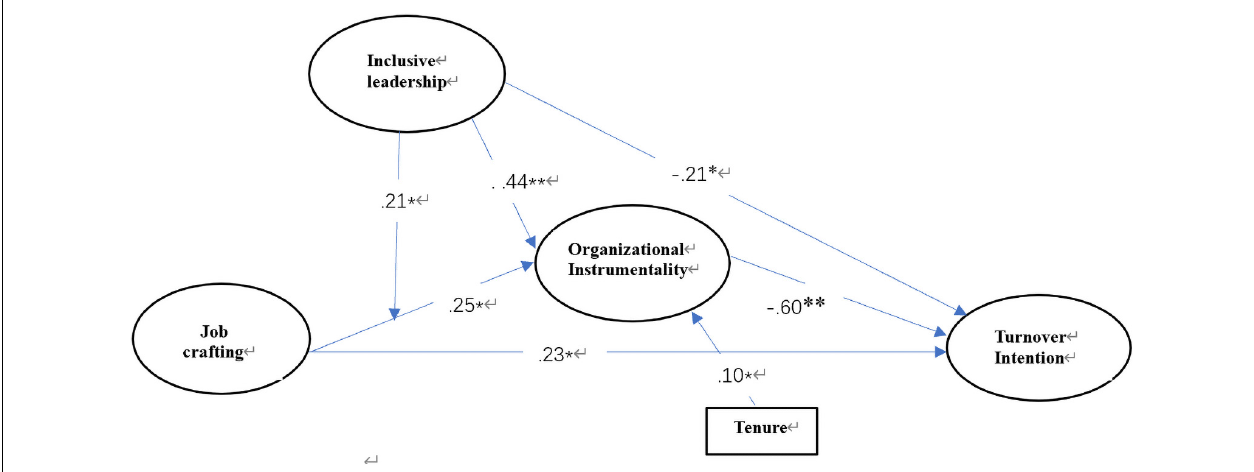
FIGURE 2 | Unstandardized path estimates of the final model. ∗ p < 0.05 and ∗∗ p < 0.01.